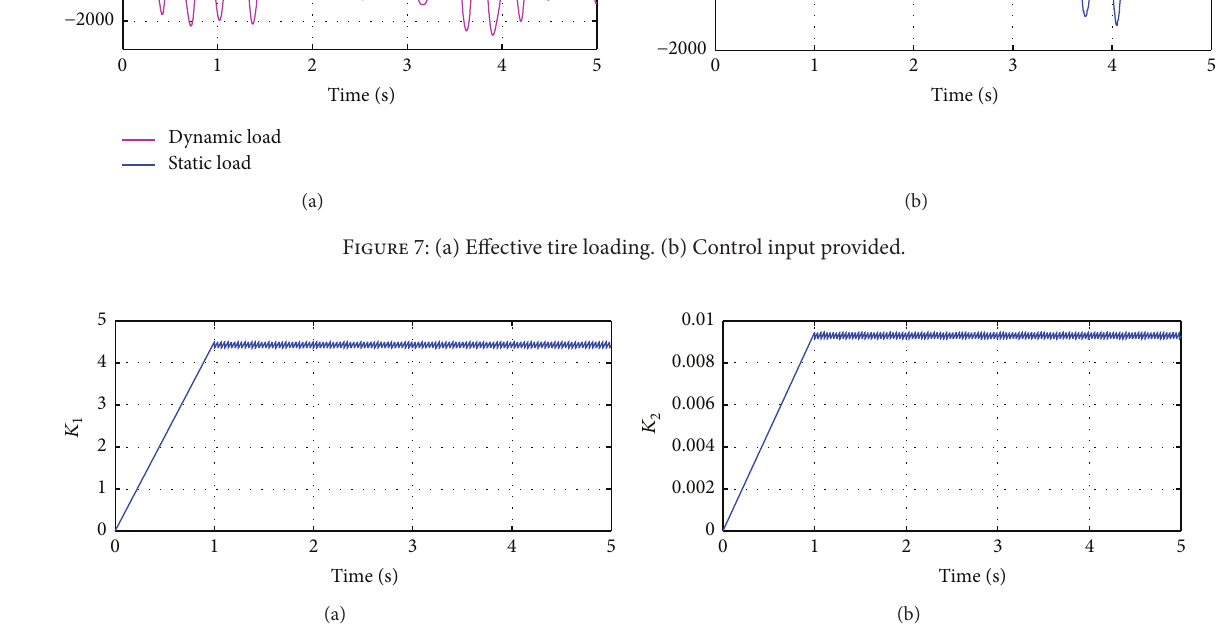
Figure 8: (a) Adaptive gain, 𝐾 1 . (b) The dynamic gain 𝐾 2 .